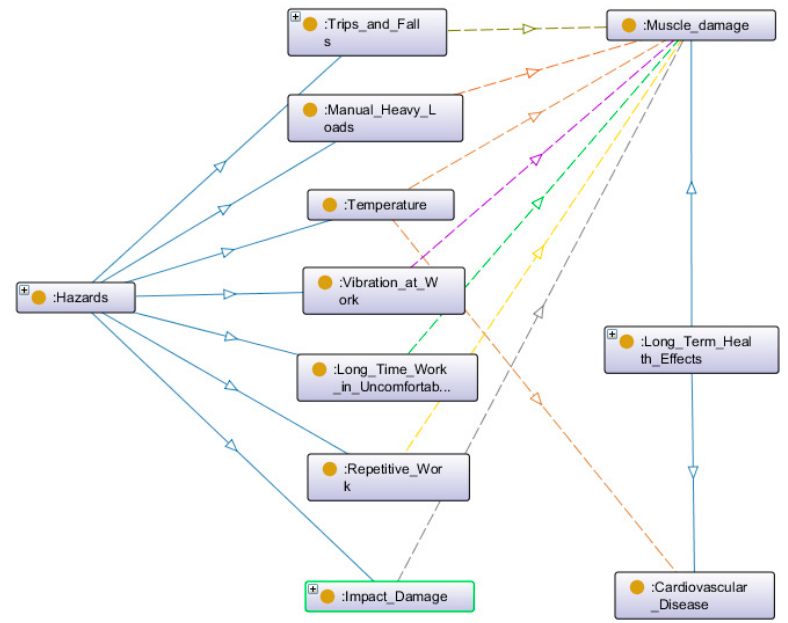
Figure 4. Relationship between safety hazards and biological consequences in Protégé.